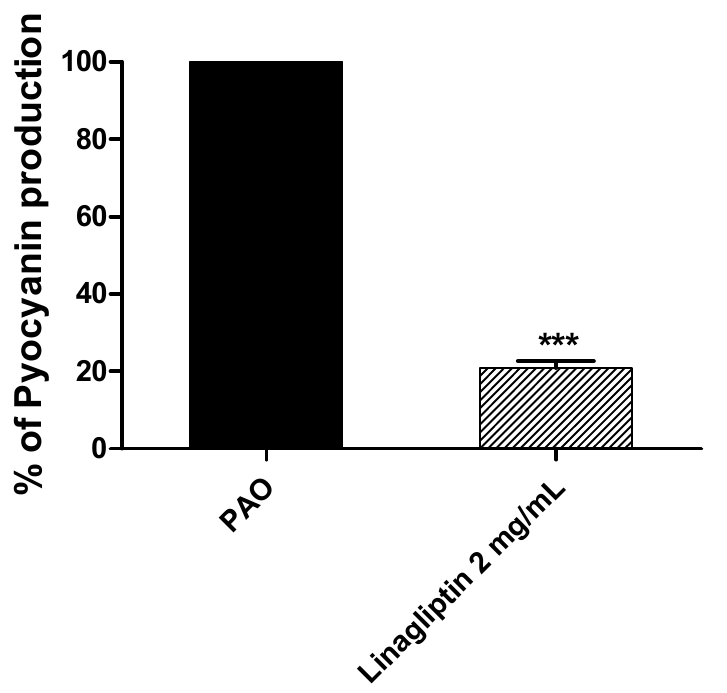
Figure 5. Linagliptin decreases the production of pyocyanin. The absorbance of the produced P. aeruginosa pigment was measured in the presence or absence of linagliptin at sub-MIC. Linagliptin significantly reduced the production of pyocyanin, *** = p ≤ 0.0001.